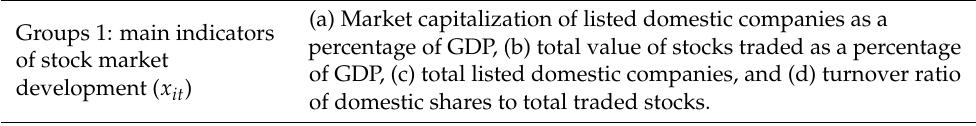
Table 1. A classification of the independent variables examined in this